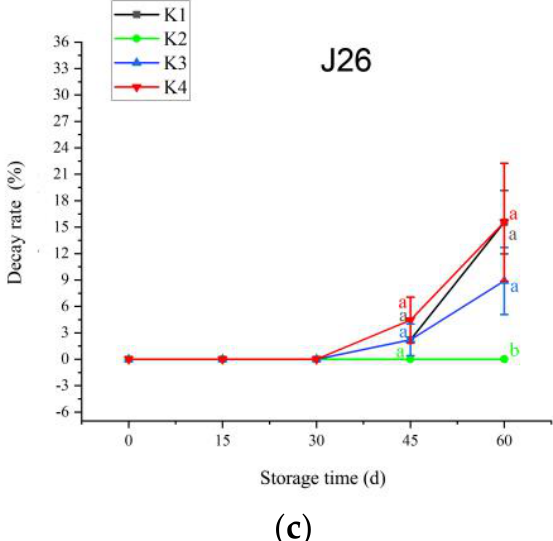
Figure 2. Decay rate of the tuberous root of different UCZ treatments during storage. ( a ) Z13; ( b ) Z33; ( c ) J26. Values within the same storage day followed by the same letter are not significantly different at the 5% level according to ANOVA- Duncan’s multiple range test. The bar represents standard deviation. K1: Normal basal fertilizing without UCZ; K2: Normal basal fertilizing with UCZ; K3: Rich basal fertilizing without UCZ; K4: Rich basal fertilizing with UCZ.